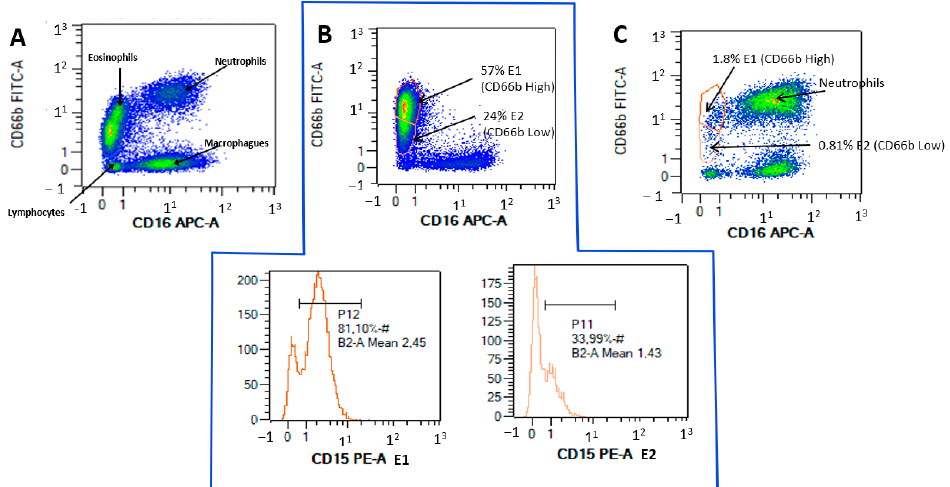
Figure 1. ( A ): Flow cytometry for a patient presenting all cell lines, based on CD16 APC-A and CD66B FITC-A. ( B ): A highly eosinophilic patient with E1 predominance over E2 (57% vs. 24%), with side plots showing CD15 expression of 81% for E1 and 33.99% for E2. ( C ): A neutrophilic patient, with few E1 eosinophils (1.8%) or E2 eosinophils (0.8%).